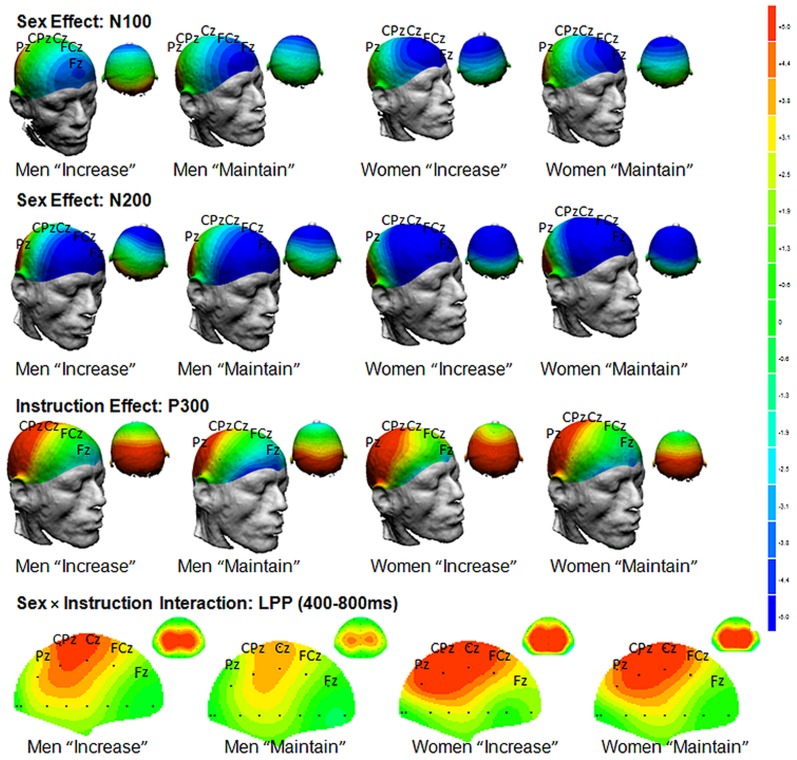
Topographies of the Sex main effects at N100 and N200 amplitude, the Instruction main effect at P300 amplitude, and the Instruction×Site×Sex interaction for mean LPP amplitude to the ‘increase” instructional set (blue negative, red positive).